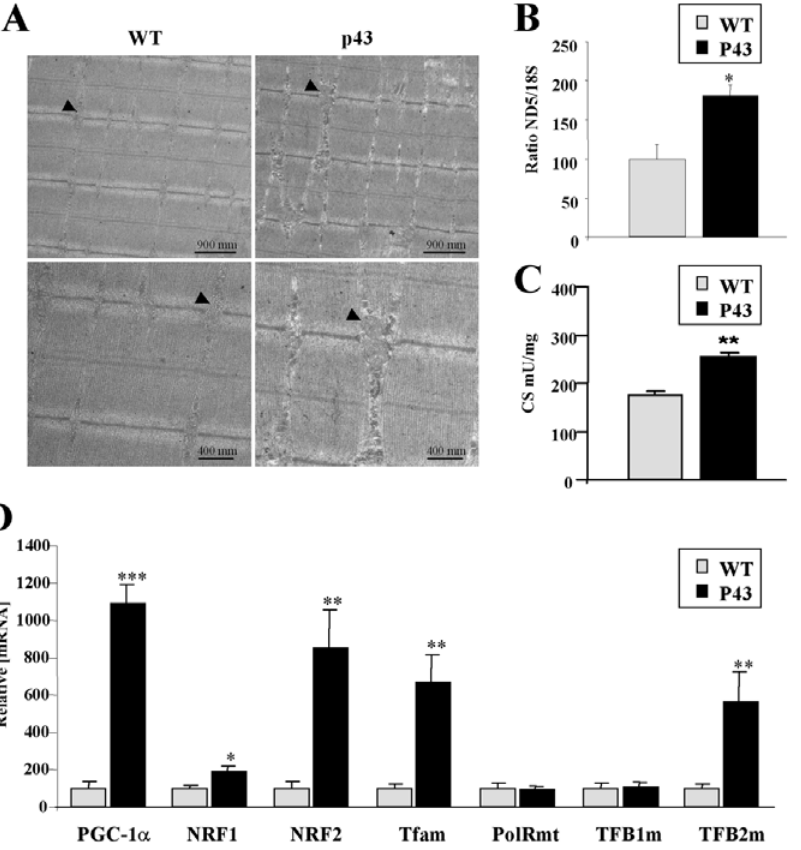
Figure 4. p43 stimulates mitochondrial biogenesis. (A) electronic microscopy experiments from longitudinal section taken from quadriceps muscle from transgenic mice of the 86 line compared to wild-type animals at 2 months of age (magnification 6 10.000 and 6 20.000). Arrows indicate mitochondria. (B) Relative mtDNA content in quadriceps muscle from transgenic mice of the 86 line compared to wild-type animals at 2 months of age (n=8 each group). After extraction of muscle DNA, quantitative PCR reactions were performed using ND5 for mtDNA copy estimation, and 18S for the nuclear genome. Ratio ND5/18S was expressed as percent of control value. *p , 0.05. (C) Citrate Synthase activity in quadriceps muscle from transgenic mice of the 86 line compared to wild-type animals at 2 months of age (n=8 each group). CS: citrate synthase. **p , 0.01. (D) Relative mRNA expression levels of the indicated genes from gastrocnemius muscle from transgenic mice of the 86 line compared to wild-type animals at 2 months of age (n=8 each group). *p , 0.05; **p , 0.01; ***p , 0.001.